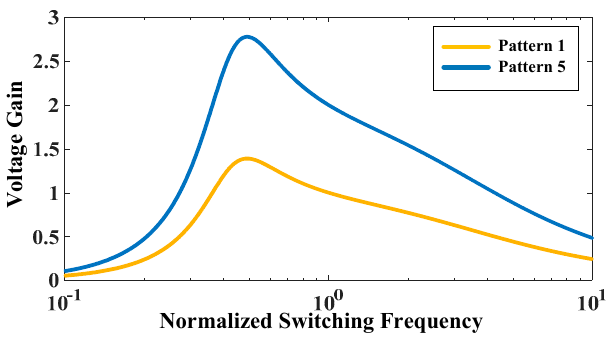
Figure 12. Voltage gain curves of Switching Patterns 1 and 5.